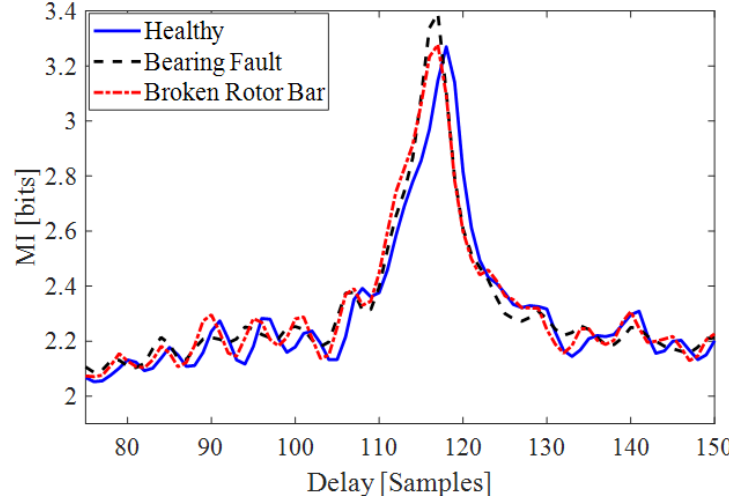
Figure 8. Analysis of the occurrence of failures in the SMI signatures—Motor 1 operating with nominal load torque and balanced